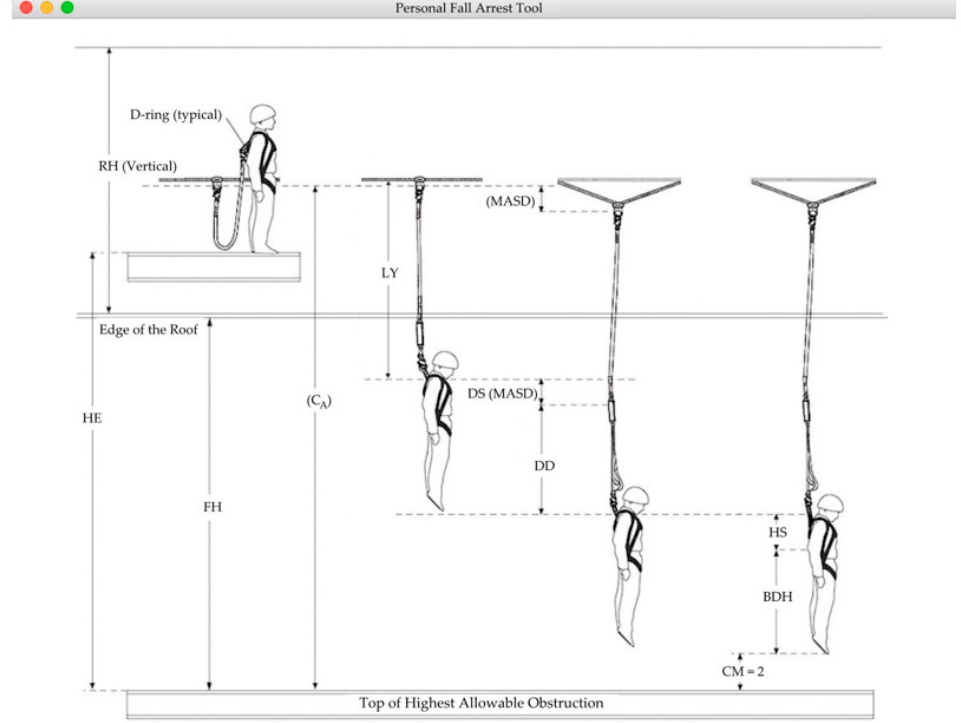
Figure 4. Fall clearance guide (adapted from American National Standards Institute (ANSI)/ASSE [14]).